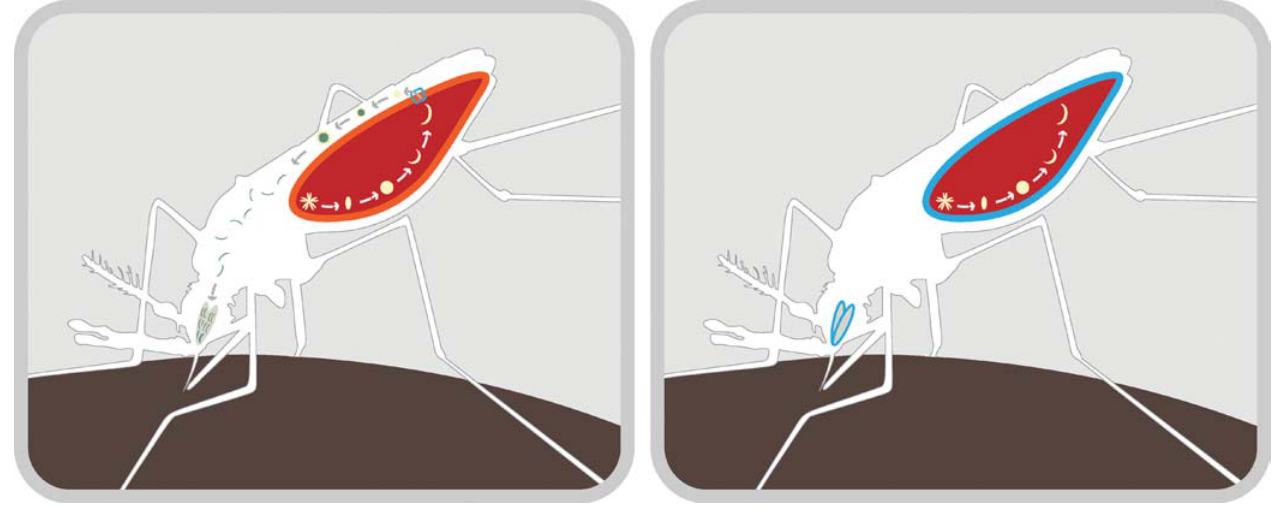
Figure 1. Mechanism for Blocking Malaria Transmission in the Mosquito Left: Mosquitoes become infected with the malaria parasite upon taking an infected human blood-meal. This produces an oocyst in the mosquito’s gut wall (light red). When the oocyst ruptures, it releases sporozoites that pass through the gut (dark red) and into the hemocoel (white). The sporozoites are then amplified and migrate through the mosquito’s body to the salivary glands, ready to infect a new human. Right: The laboratory of Marcelo Jacobs-Lorena at Johns Hopkins University has identified receptor sites for proteins that are necessary for the malaria parasite to pass through the gut wall after the oocyst ruptures. The same receptors are involved with the passage of sporozoites into the salivary glands. The laboratory has produced small proteins that preferentially occupy these sites (blue), blocking transmission of sporozoites through the gut wall and into the salivary glands. The appropriate gene constructs have been introduced into An. stephensi mosquitoes, thus rendering them refractory to P. berghei (a model system for human